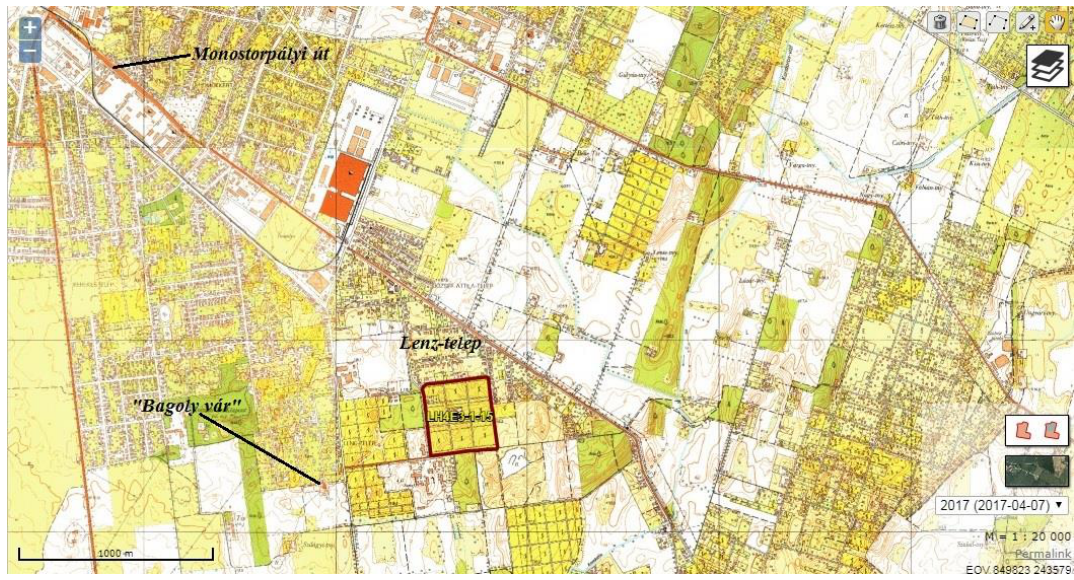
Figure 4. Remaining clues of historic vinegardens by the topographic data of MEPAR system Table 1. Yield of the 11 vinegardens of Debrecen between 1861 and 1918 (HBML. Debreceni Tára IV.B. 1405/b; ill. U.o. 1414/b from 1877 to 1916)